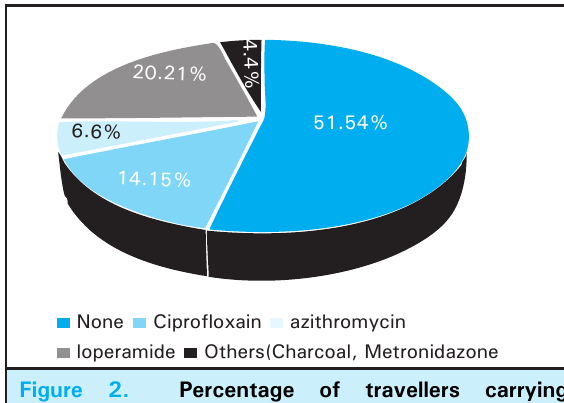
Figure 2. Percentage of travellers carrying medications for traveller’s diarrhea.